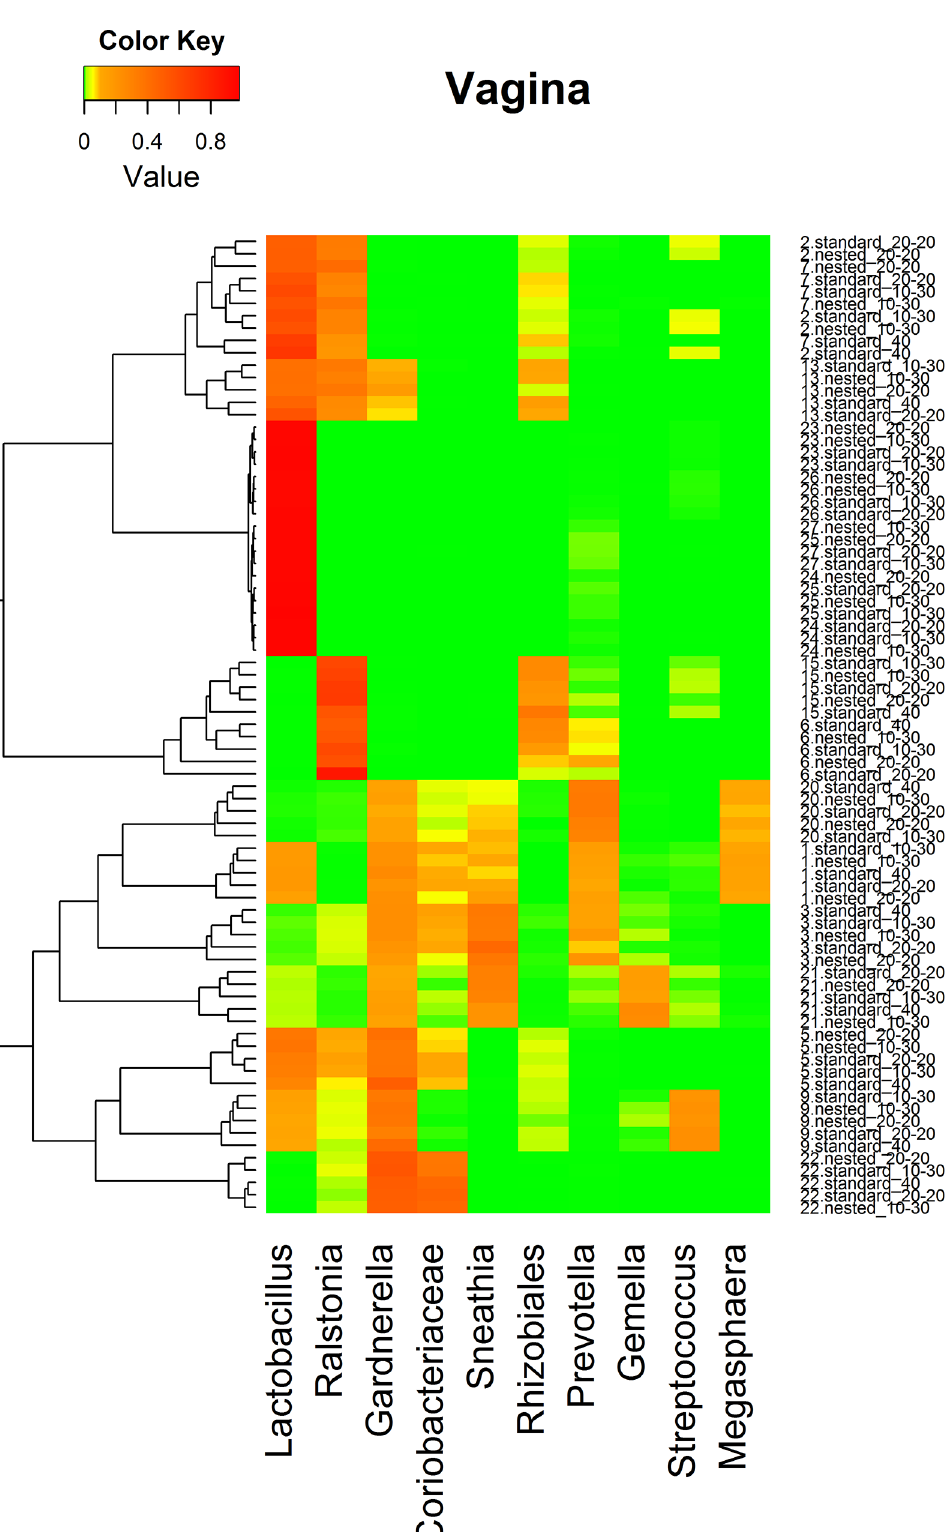
PLOS ONE | DOI:10.1371/journal.pone.0132253 July 21,